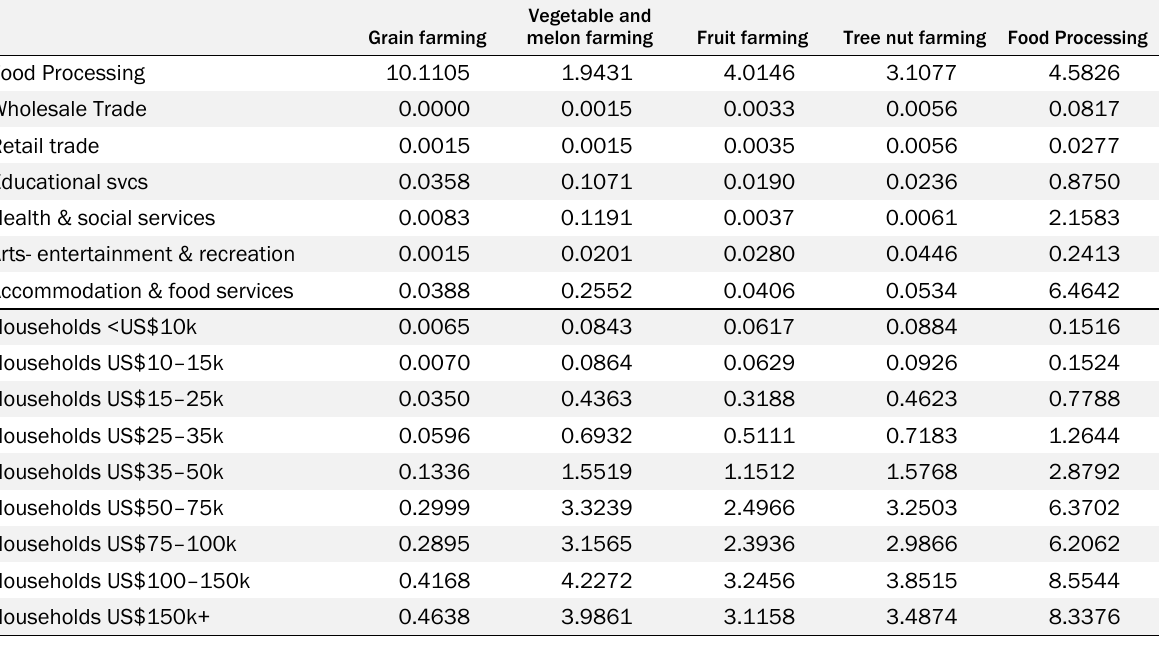
Table 8. Percent Change in Aggregate Multipliers Corresponding to Row Changes in Demand for Column